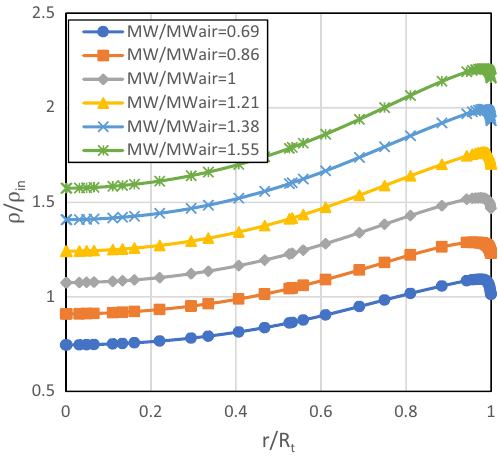
Fig. 10 Dimensionless density profiles versus dimensionless radial direction plotted at z∕L = 0.63 for various molecular weight ratios with 400 kPa at the inlet, 0 kPa at the cold outlet and 30 kPa at the hot